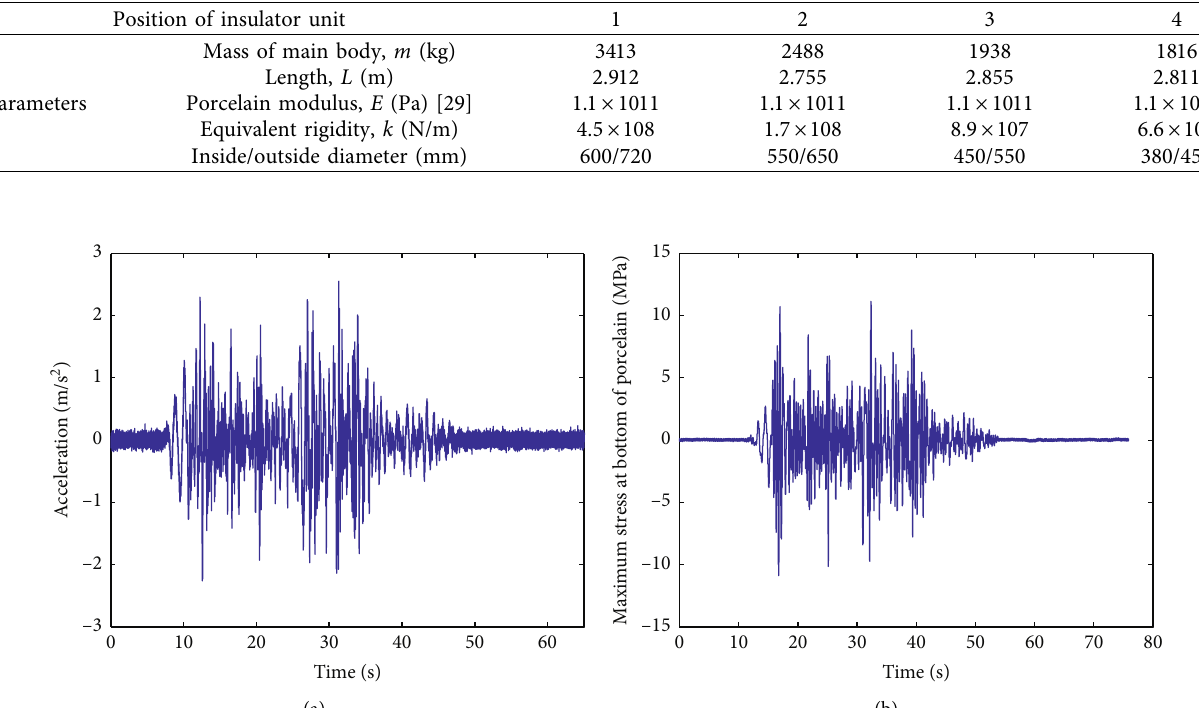
Figure 8: The diagram of the shaking table test. (a) Shaking table test set-up. (b) Sensor arrangement. Table 1: Model parameters of insulators in a 1000kV porcelain surge arrester.